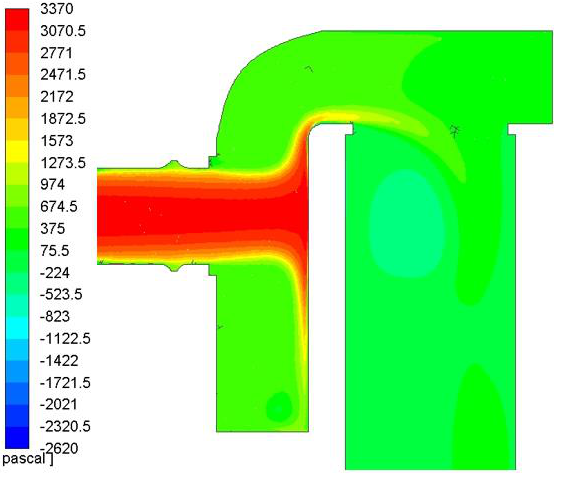
Fig. 11. Contours of Total Pressure p / Pa: unmodified